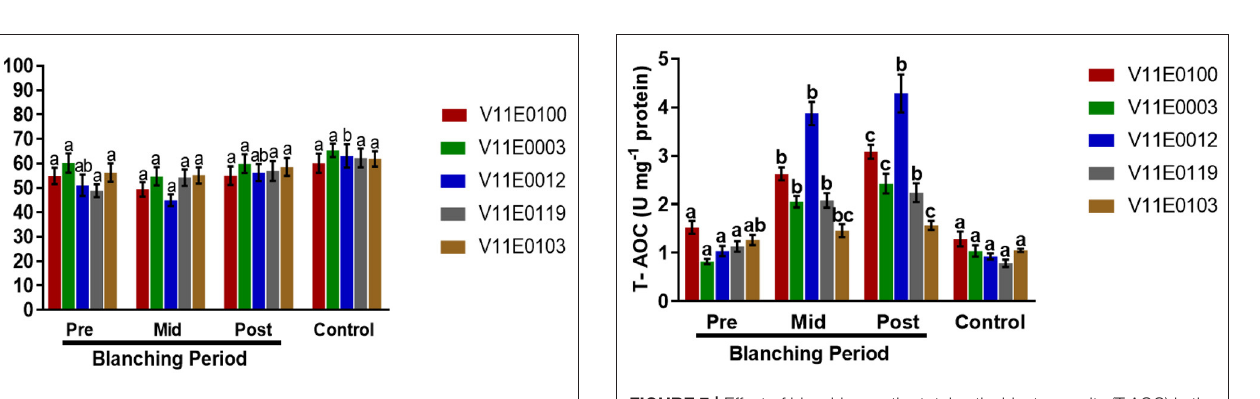
FIGURE 7 | Effect of blanching on the total antioxidant capacity (T-AOC) in the stem of five water dropwort cultivars. Four types of samples were analyzed; Pre-blanching, Mid-blanching (20 days), Post-blanching (40 days), and Control (grown under normal conditions). Different letters indicate a significant difference ( P < 0.05) among the treatments according to the Tukey test. Values are means ± SE.